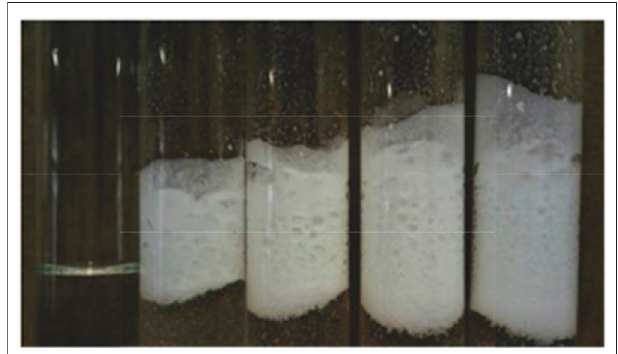
FIGURE 1 | Foam structure with different ethanol concentrations (From left to right: 20.0 vol%, 30.0 vol%, 40.0 vol%, and 50.0 vol% ethanol; PTFE, 20 μ m, 1.0 wt%).